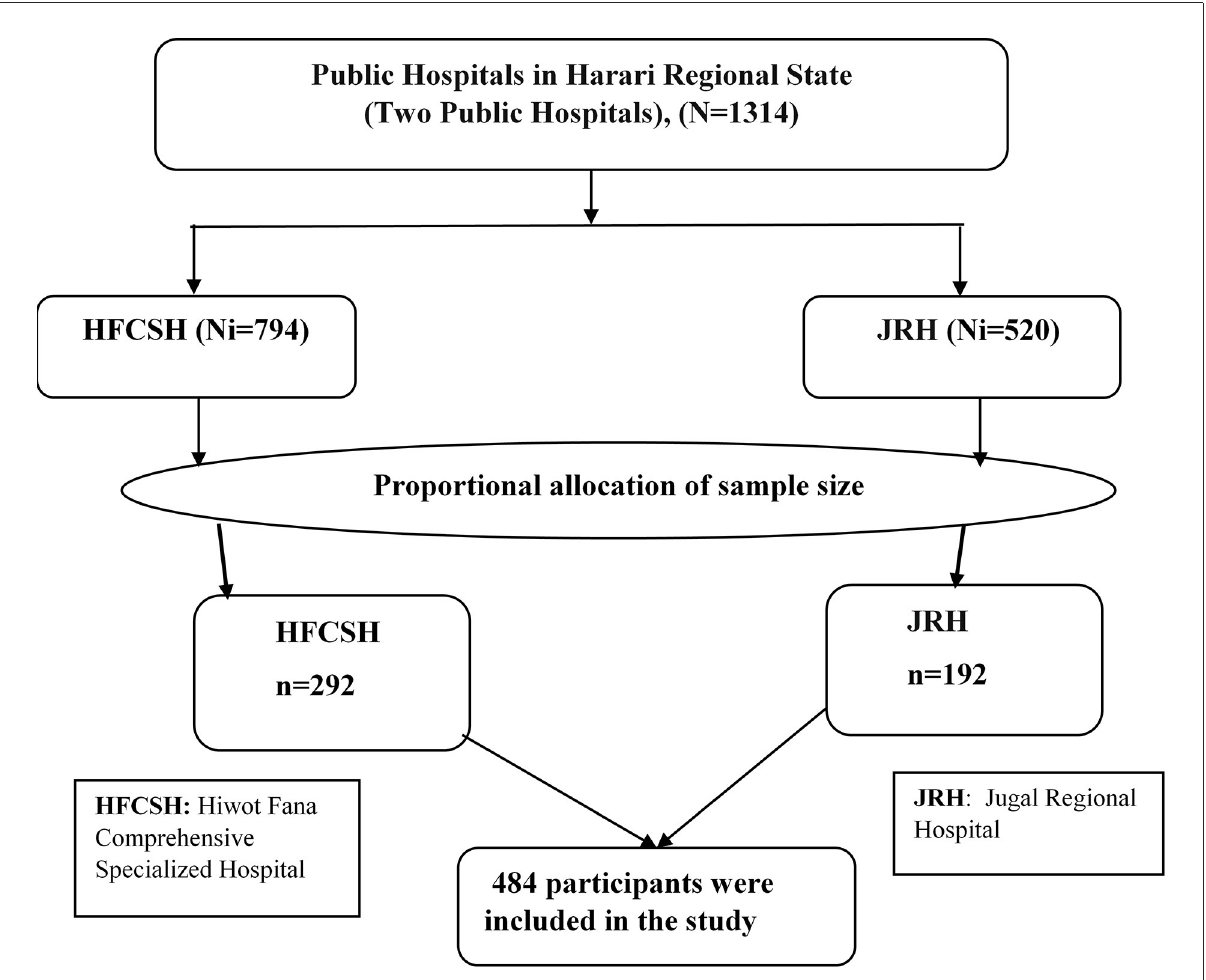
FIGURE1 Schematic presentation of sampling procedure to select immediate postpartum women admitted to the maternity ward in public hospitals in Harari Regional State, Eastern Ethiopia,